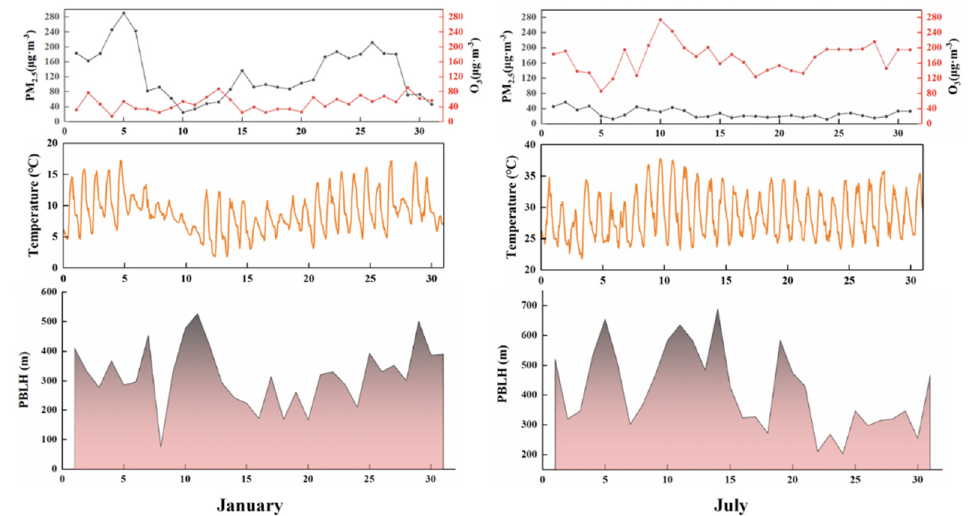
Figure 9. Daily changes in PM 2.5 , MDA8 O 3 , temperature, and PBLH.